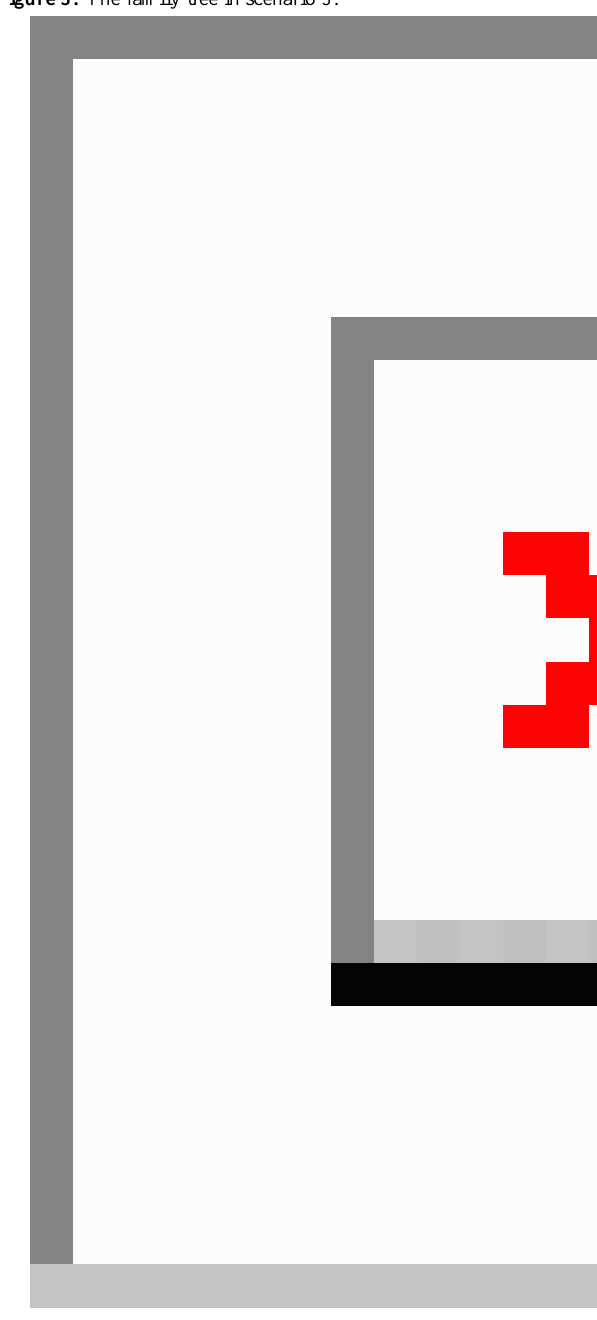
Figure 3. The family tree in scenario